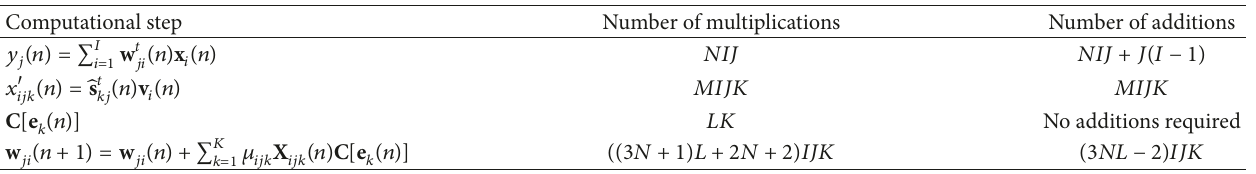
Table 1: Description of the FXECAP-L algorithm, the number of multiplications, and the number of additions required ( 𝐼 reference sensors, 𝐽 actuators, and 𝐾 error sensors).